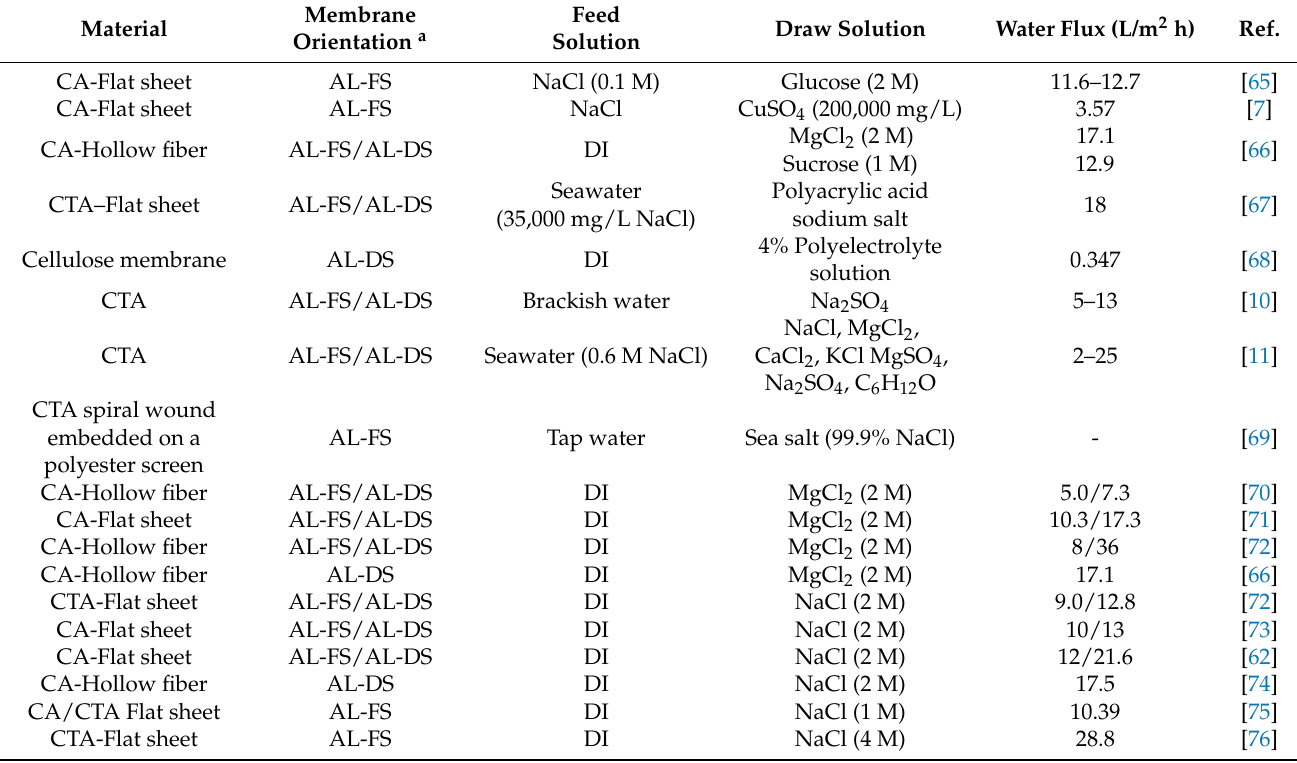
Table 1. Applications of different configurations of CA/CTA FO membranes in water